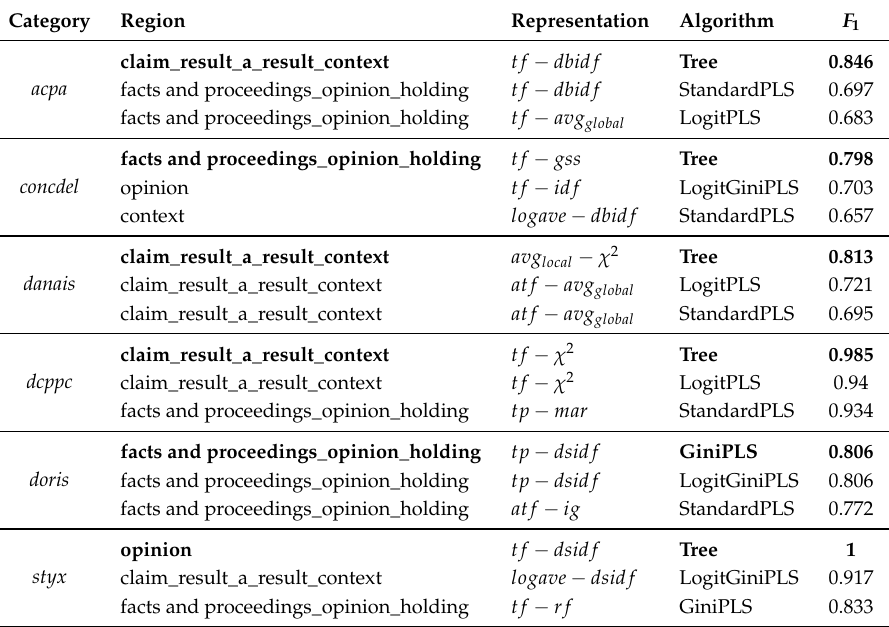
Table 10. Accuracy of the classification with restriction of judgments to specific